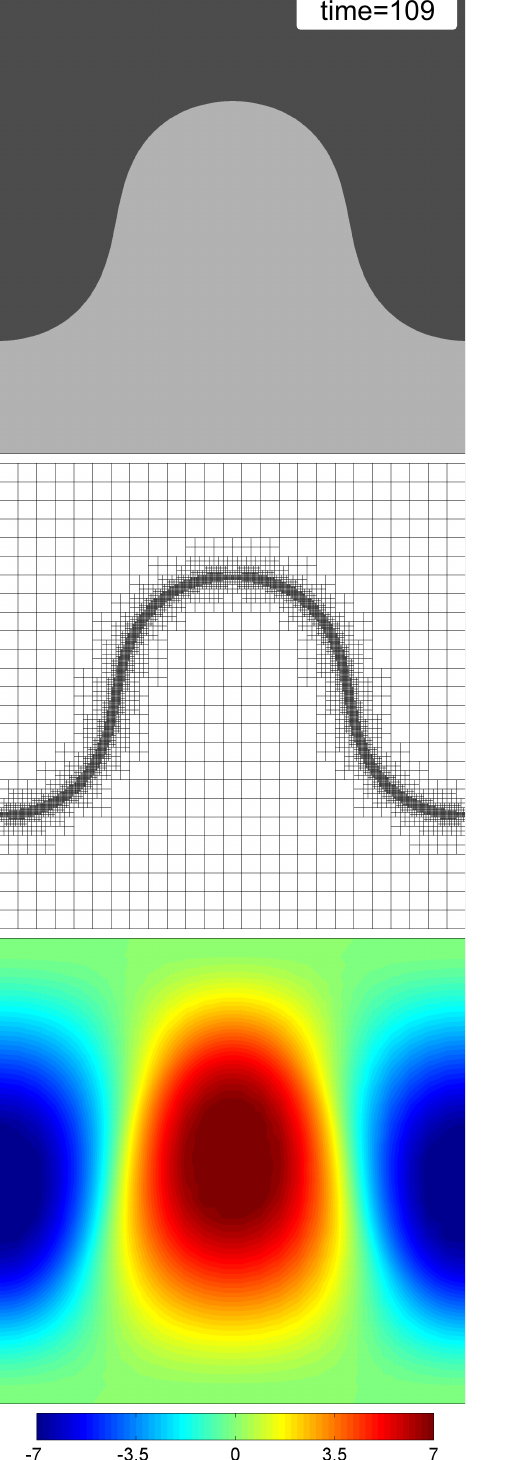
Figure 31. Results of Rayleigh-Taylor numerical experiment with η 1 numerical grid; bottom : v y -velocity